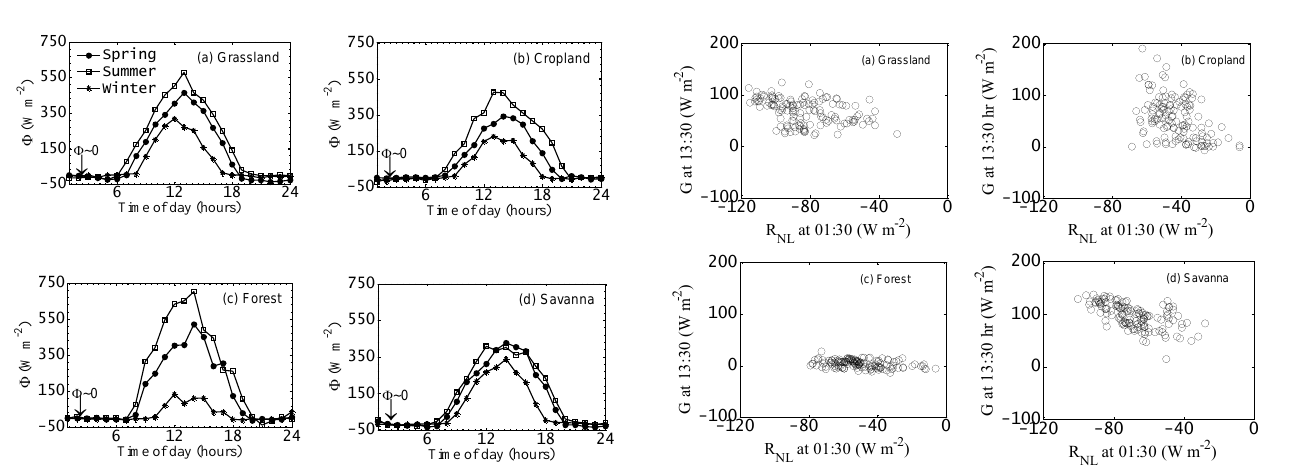
Figure 4. Observational relationship night-time (01:30LT) net longwave radiation ( R NL ) and midday (13:30LT) G measurements. Despite the scale mismatch between the two measurements, moder- ate ( r = 0.32–0.44) (forest, cropland) to high ( r = 0.60) (grassland and savanna) relationship is